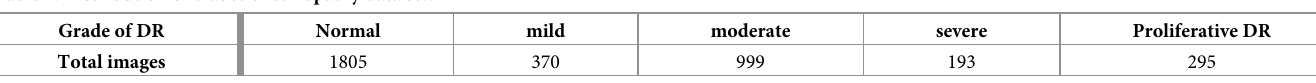
Table 2. Distribution of diabetic retinopathy data